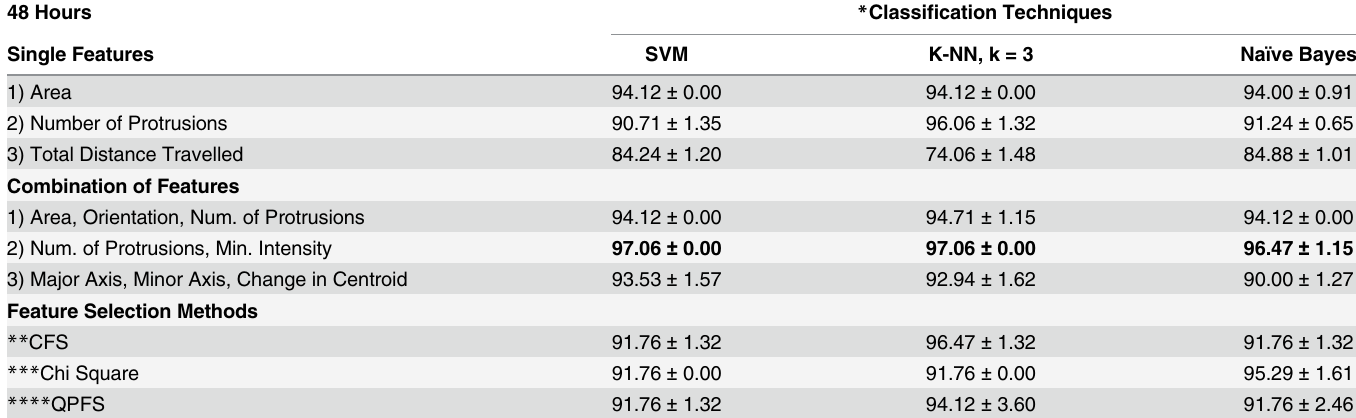
Table 1. Classification Results Using 48 Hours of Video.